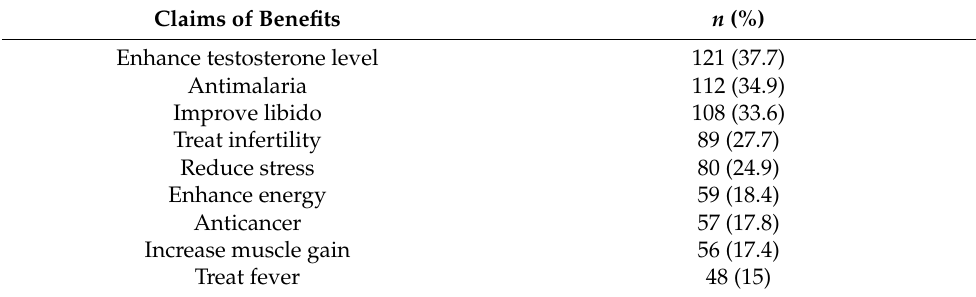
Table 2. Health claims for TA in the